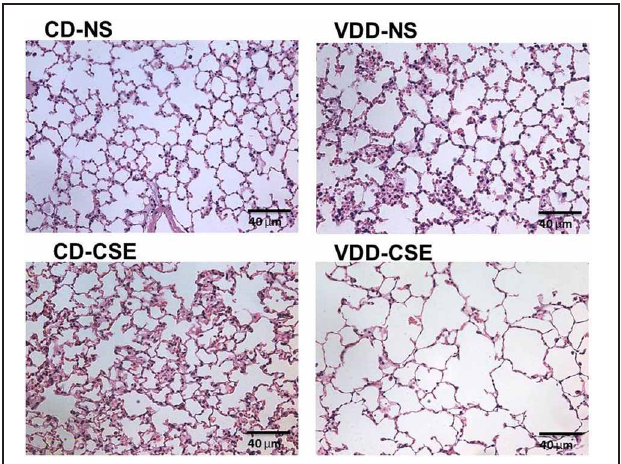
FIGURE 2 | Normal and emphysema-like features in hematoxylin and eosin (H&E) stained sections of lung representative of lung sections from each treatment group. All images are 40 × enlargements.